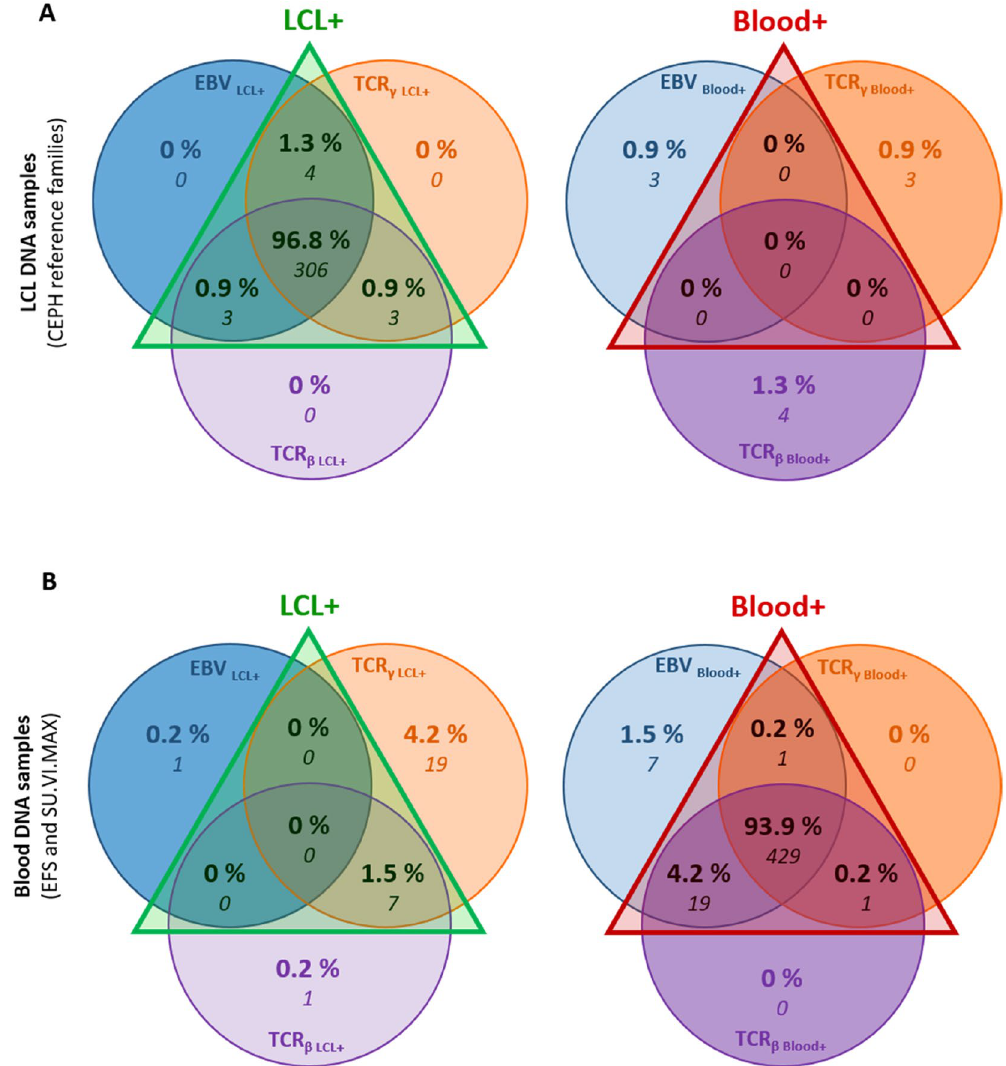
Figure 2. Venn diagrams of the results using combination of the three real-time PCR assays ( EBV , TCR γ and TCR β ) from blood and LCL DNA of known origin. ( A ) LCL DNA samples from CEPH reference families (n = 316) distribution. ( B ) Blood DNA samples from EFS and SU.VI.MAX (n = 457) distribution. When there was a discrepancy between the results of the three tests, these samples were represented on both the left and right Venn diagrams. For each Venn Diagram, the percentages are calculated from the total number of blood (316 for panel A ) and LCL (457 for panel B ) reference DNA